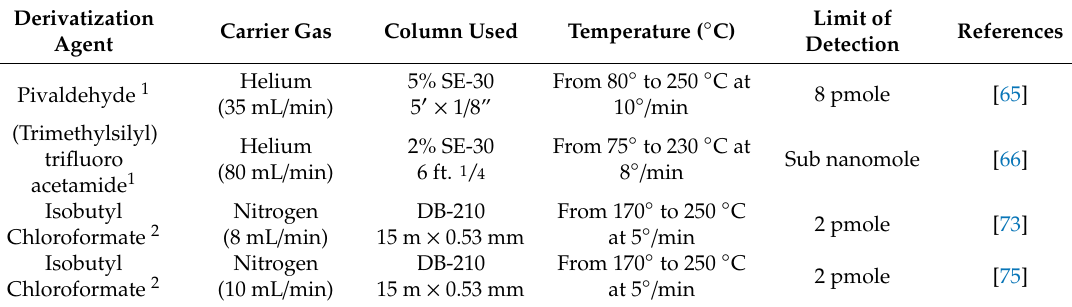
Table 4. Gas chromatography detection of